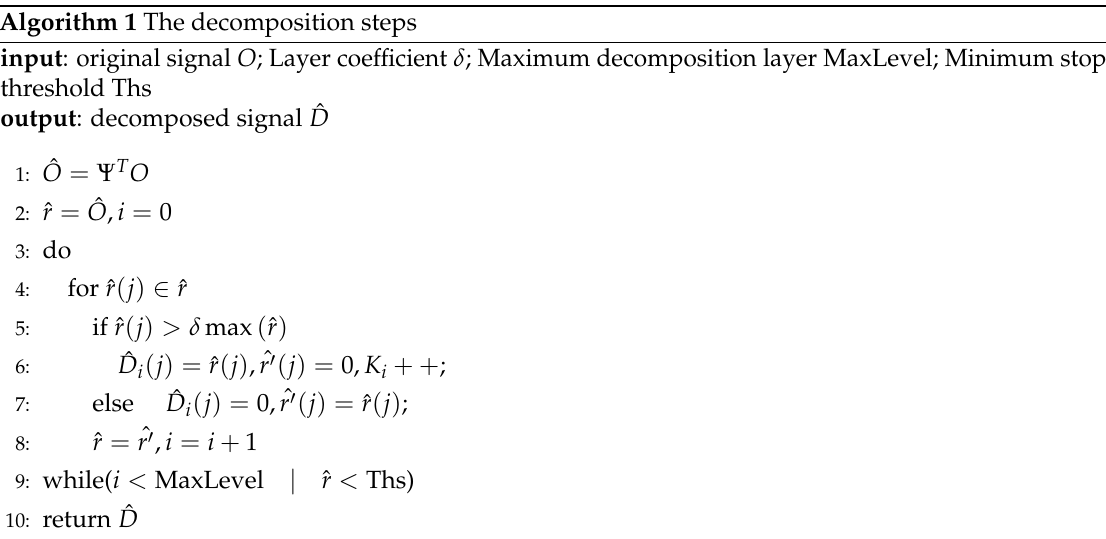
Algorithm 1 The decomposition